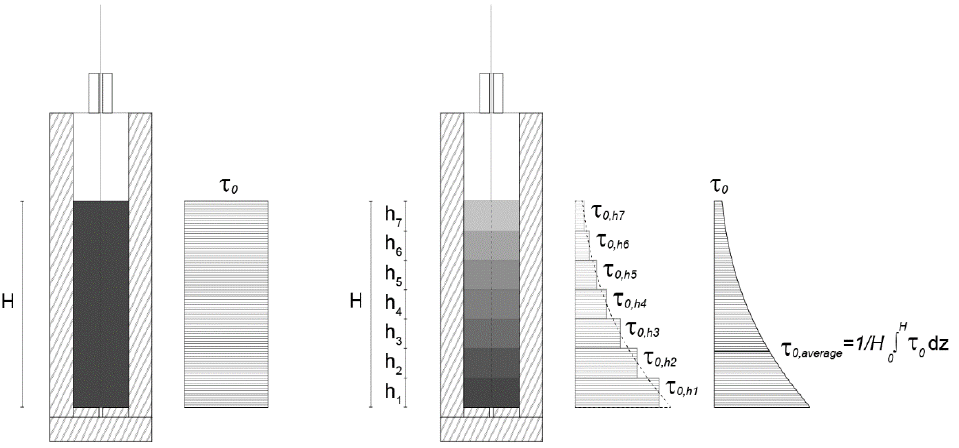
Figure 12. Yield stress of the concrete filled into the container at once ( left ) and gradually ( right ).